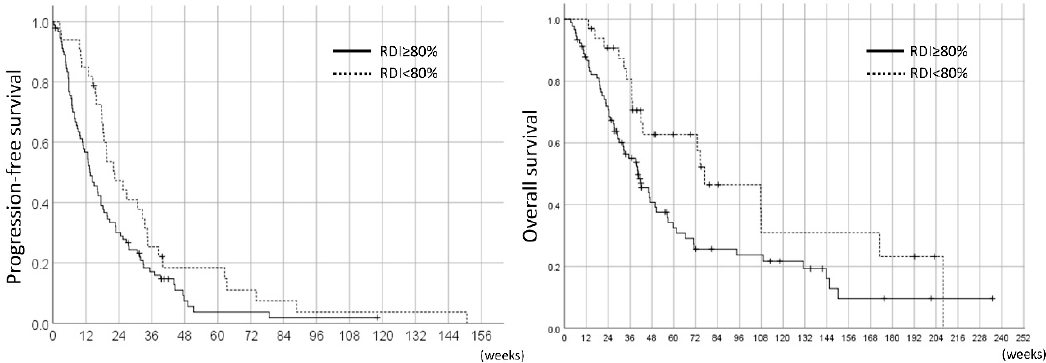
Figure 4. PFS and overall survival (OS) in the 124 pazopanib-treated STS patients by RDI throughout treatment periods.